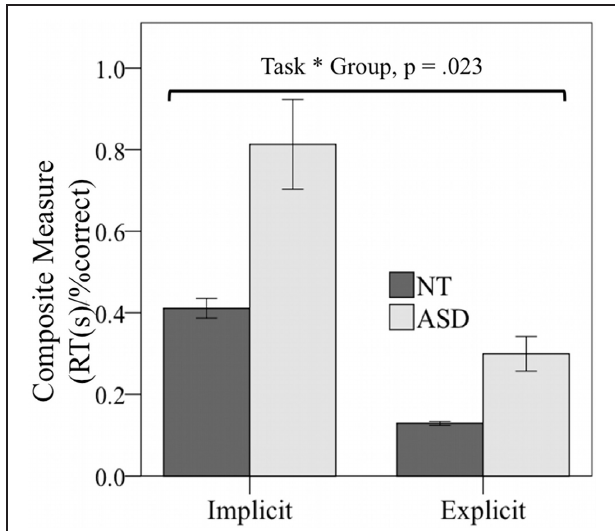
FIGURE 3 | Significant TASK (implicit vs. Explicit) by GROUP (ASD vs. NT) interaction of the composite measure [RT (seconds)/% correct responses] ( p = 0 . 023). The group difference was greater for the implicit as compared to the explicit task, indicating increased implicit processing impairments in ASD. Abbreviations: Reaction Times, RT; seconds,